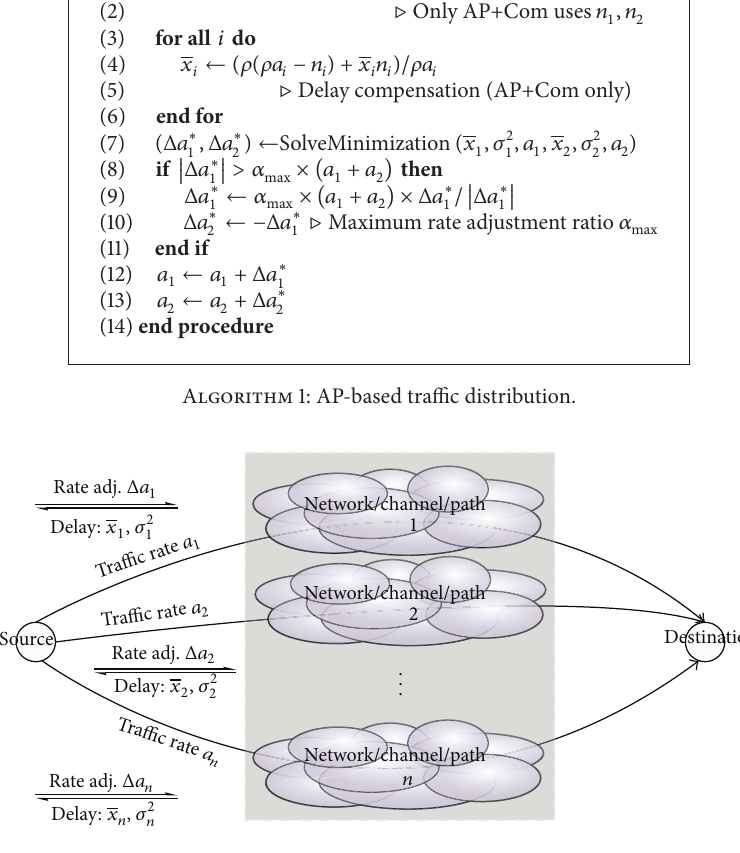
Figure 2: Overall system